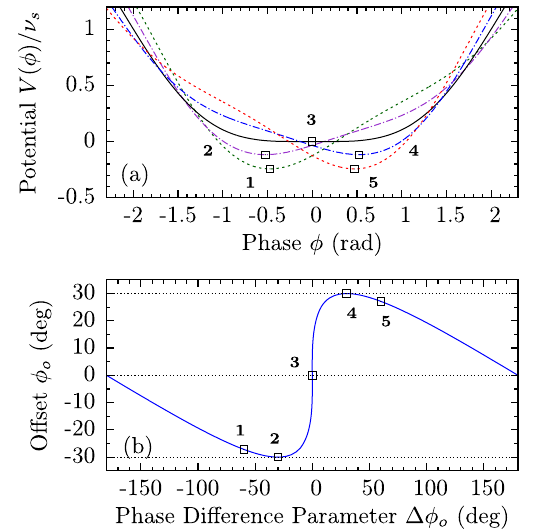
FIG. 2. (a) rf potential V ð ϕ Þ as a function of longitudinal phase ϕ for r ¼ 1 = 2 and h ¼ 2 . The boxes denote each respective potential minimum where the rf phase difference parameters are ¼ − 60 °, (2) − 30 °, (3) 0°, (4) 30°, and (5) 60°. (b) The (1) Δ ϕ o resulting potential-minimum offset ϕ